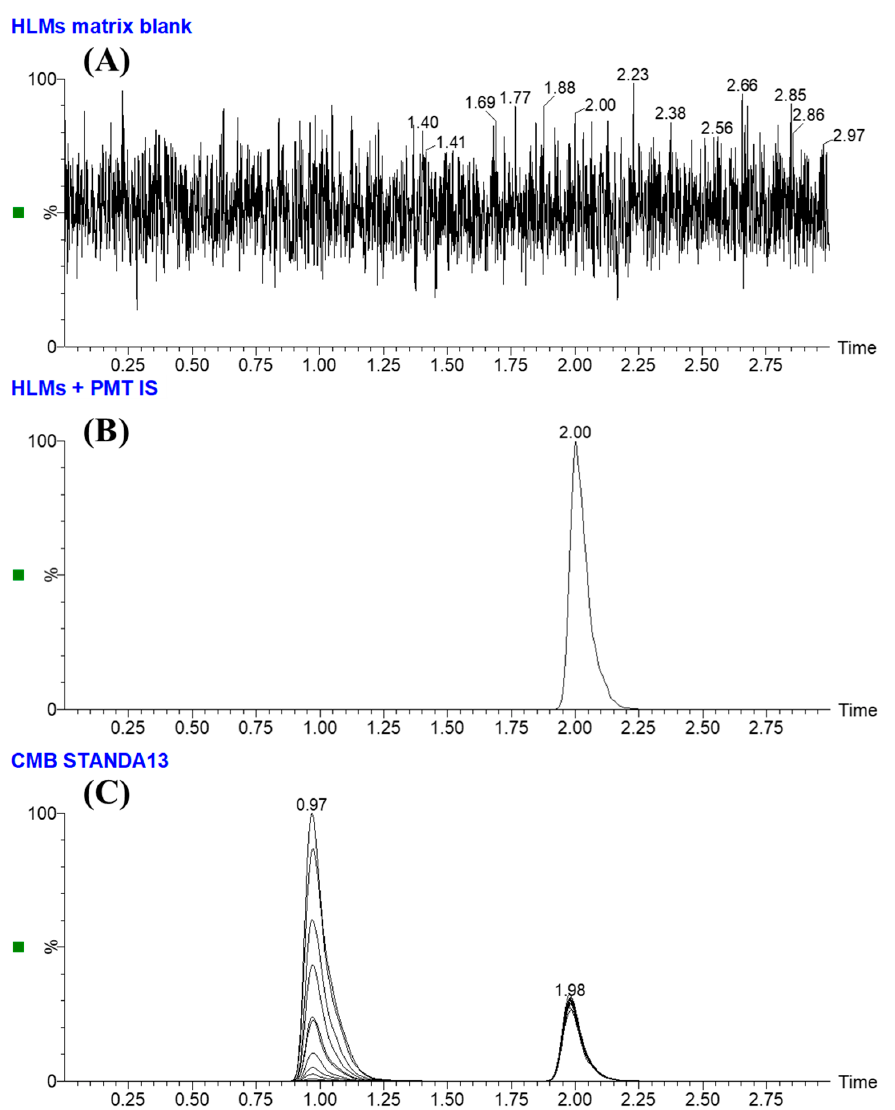
Figure 4. ( A ) Blank human liver microsome (HLM) matrix showing no endogenous chromatographic peaks at the time of elution of capmatinib (CMB) and pemigatinib (PMT); ( B ) multiple reaction monitoring (MRM) chromatogram of blank HLMs plus PMT (1000 ng/mL); ( C ) overlaid MRM chromatograms of the nine CMB calibration standards (1, 15, 50, 100, 200, 400, 500, 1500, and 3000 ng/mL) and the three QCs (3, 900, and 2400 ng/mL) showing the CMB peaks (0.97 min) and PMT peak (1000 ng/mL; 1.98 min).